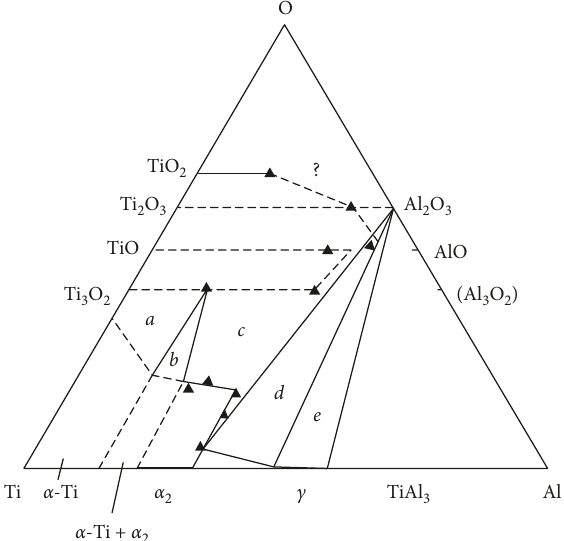
Figure 7: Incomplete phase diagram of Al-Ti-O based on ex- perimental data. Coexisting phases in (a) α -(Ti, AI) +oxide; (b) α -(Ti, Al) + α 2 -Ti 3 Al +oxide; (c) α 2 -Ti 3 Al +oxide; (d) α 2 -Ti 3 Al + c - TiAl+oxide; (e) c -TiAl+oxide [( α -Ti,A1) α -Ti]